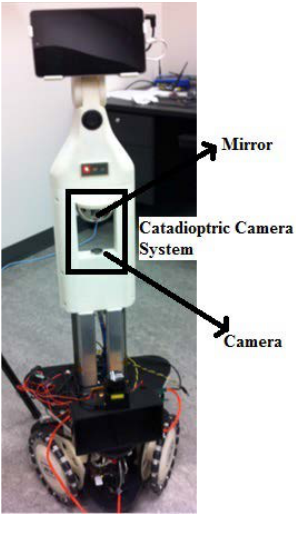
Figure 2. Mobile robot